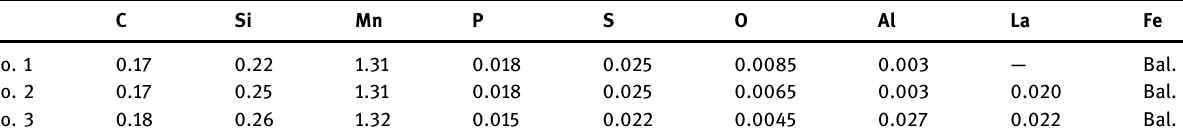
Table 1: Chemical compositions of experimental ingots ( wt%